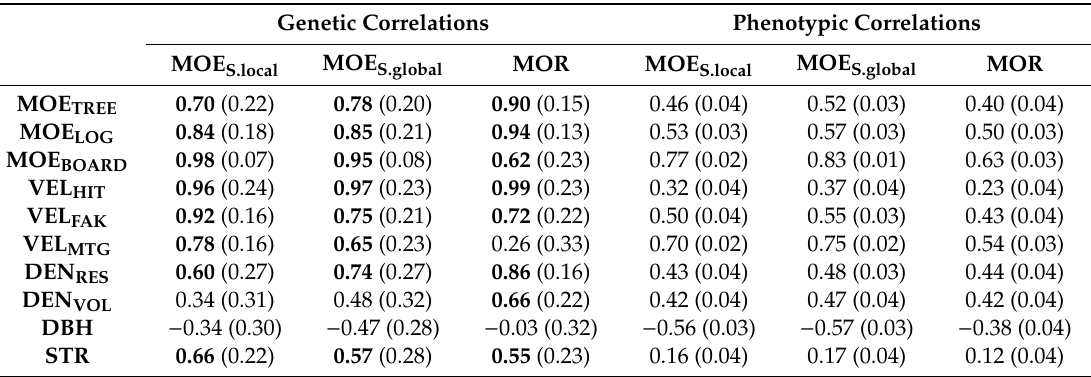
Table 3. Additive genetic ( r A ) and phenotypic ( r P ) correlations of destructively measured target traits (MOE S.local , MOE S.global and MOR) with di ff erent dynamic moduli of elasticity, acoustic velocities, densities and growth traits (standard errors in parentheses).